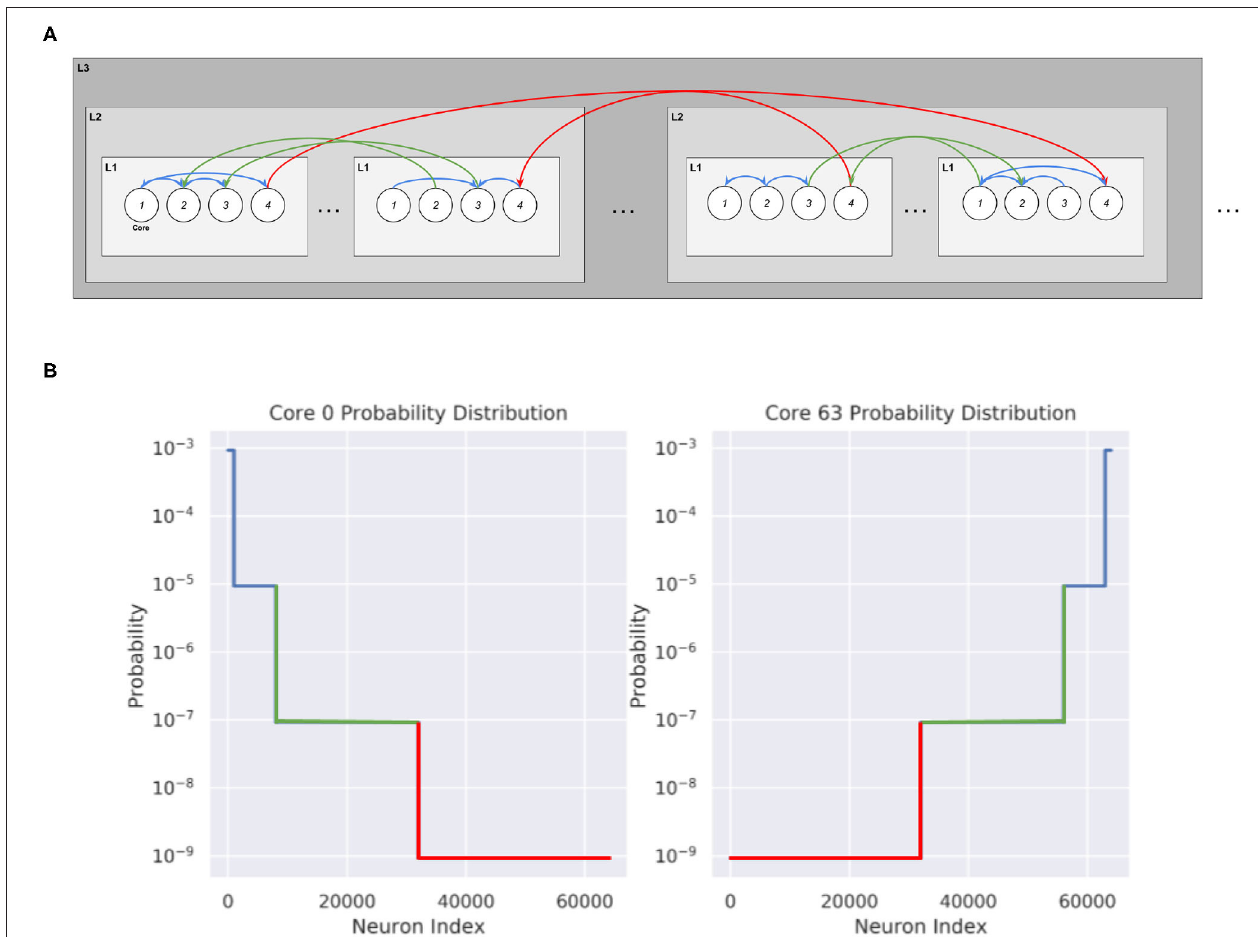
FIGURE 4 | Synthetic network connectivity and probability distribution of cores when λ = 0.01. (A) Hierarchical Routing structure within the cores obtained from the Synthetic Network Partitioning. The probability of connection decreases as the level of hierarchy increases. (B) Probability distribution of 2 cores in a 64,000 neuron Synthetic network, organized into 2 × 8 × 4. Each core contains 1,000 neurons, with core 0 containing the first 1,000 neurons of the network and core 63 containing the last 1,000 neurons of the